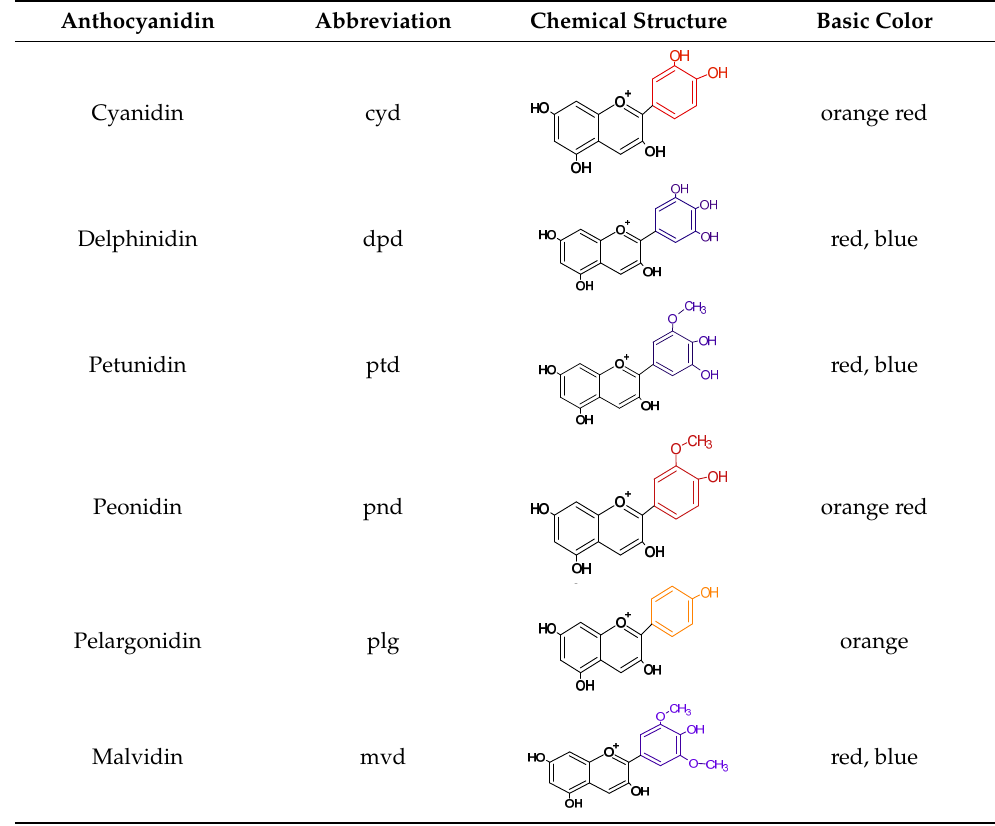
Table 1. Common anthocyanidins found in food matrices [4].